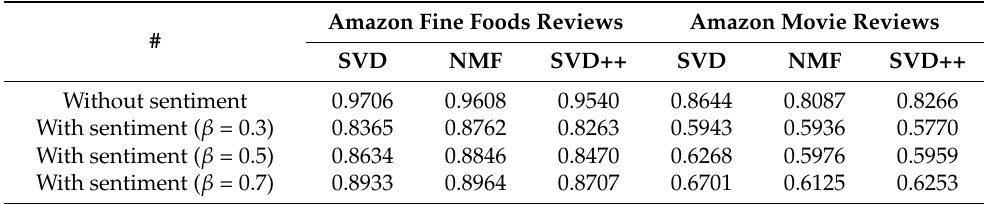
Table 3. MAE values without and with L-CNN sentiment analysis